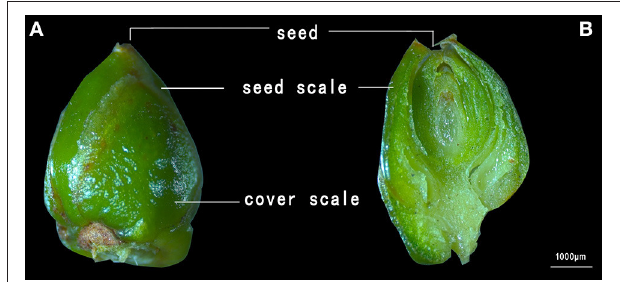
FIGURE 1 | A microscopic photograph of a Torreya grandis cv. “Merrillii” seed before (A) and after (B) the protrusion of the seed from the seed